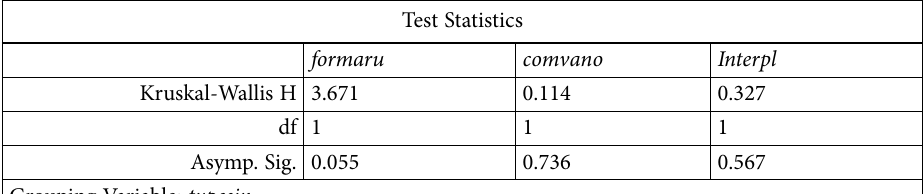
Table 6. Kruskal Wallis test – H2 (source: authors’